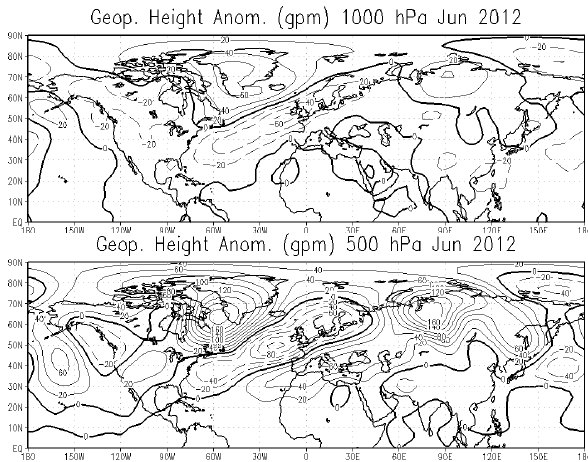
Figure 4. As Figure 1 but for June 2012